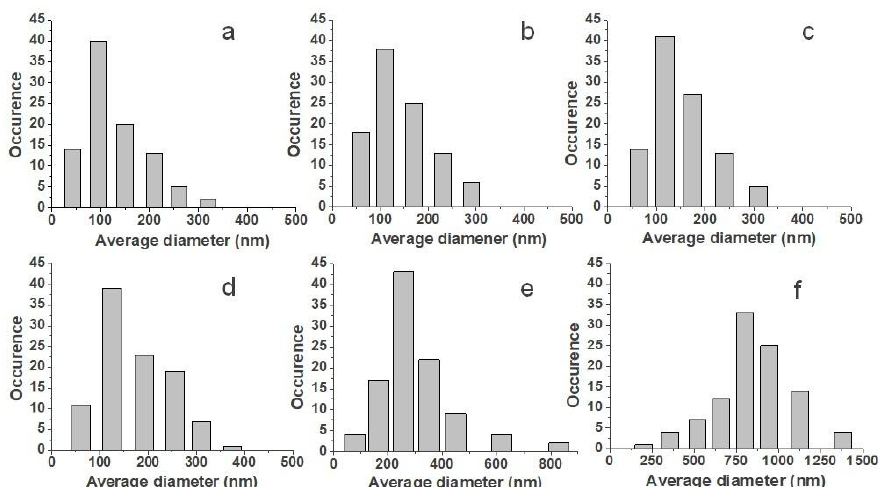
Figure 2. Distributions of fibers diameters: PCL ( a ), PCL/2% N ( b ), PCL/6% N ( c ), PCL/12% N ( d ), PCL/25% N ( e ), and PCL/50% N ( f ) fibrous membranes.